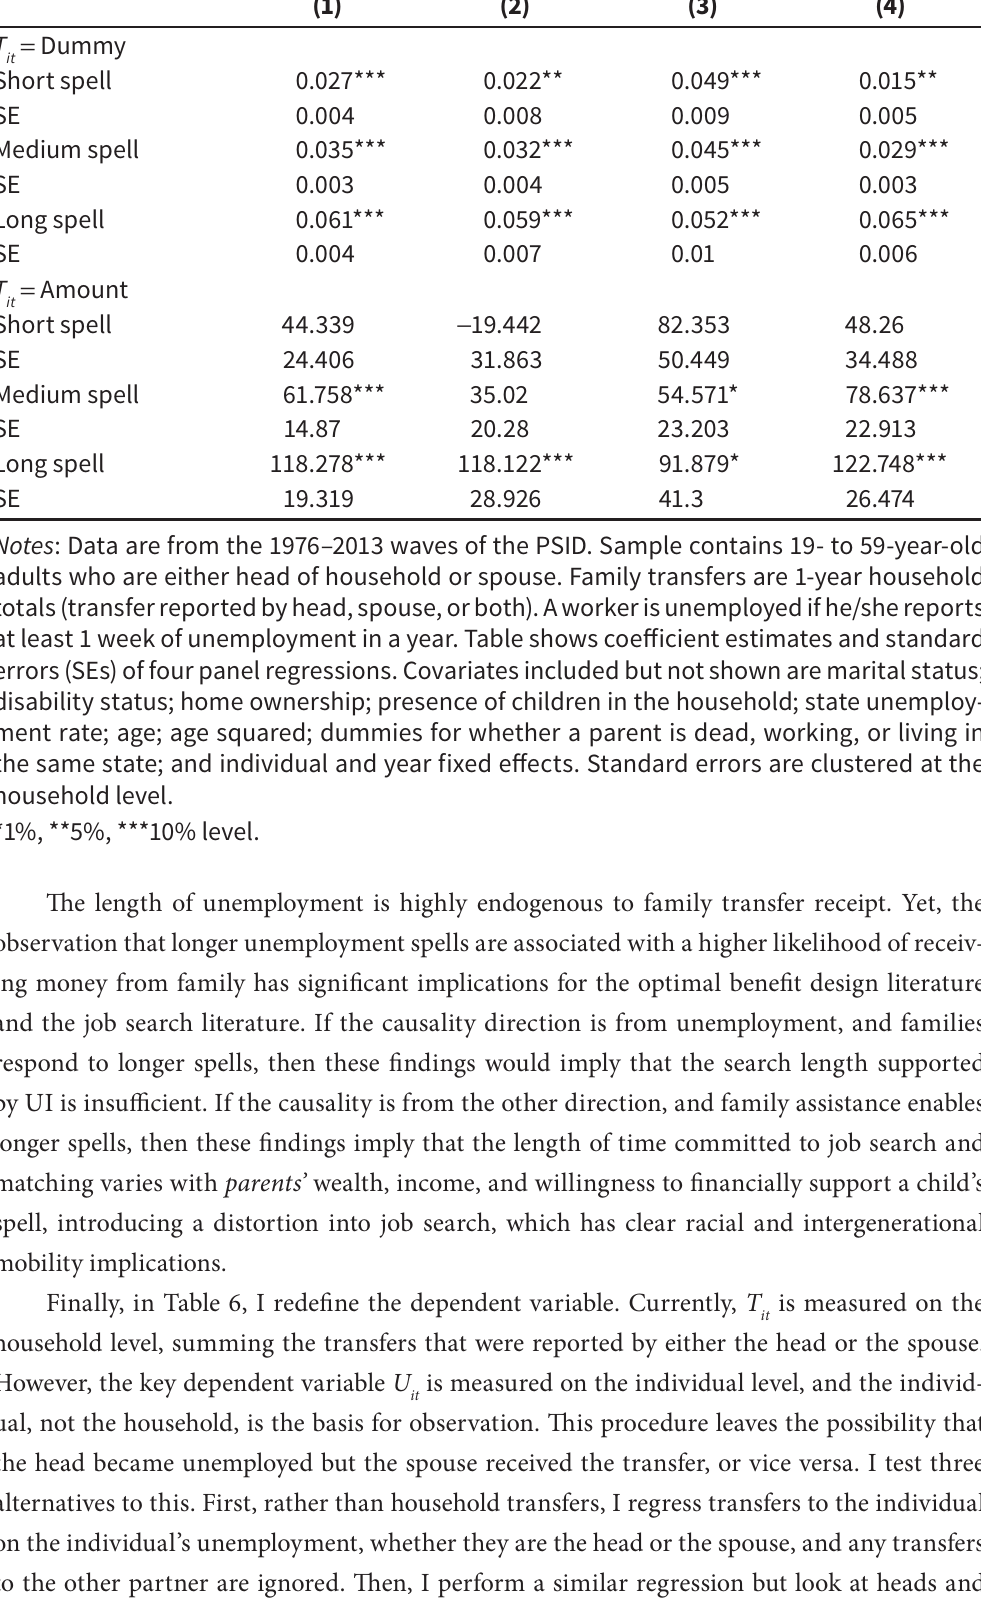
Coefficient estimate of regression of family transfer receipt on unemployment, by length of spell, heads of household and spouses aged 19–59 years, 1976–2013 PSID All spells Displaced Voluntary Not